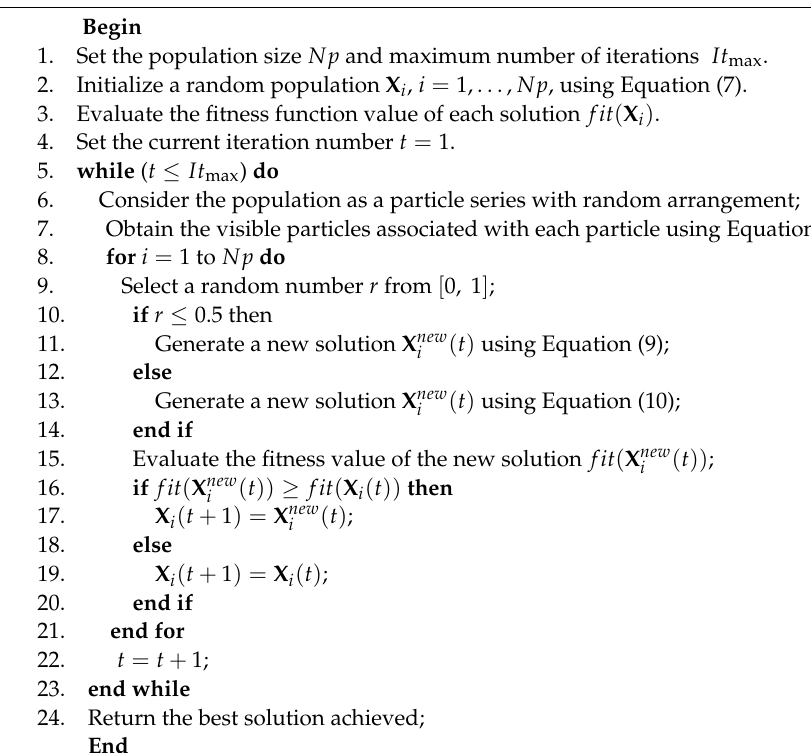
Algorithm 1. Visible particle series search